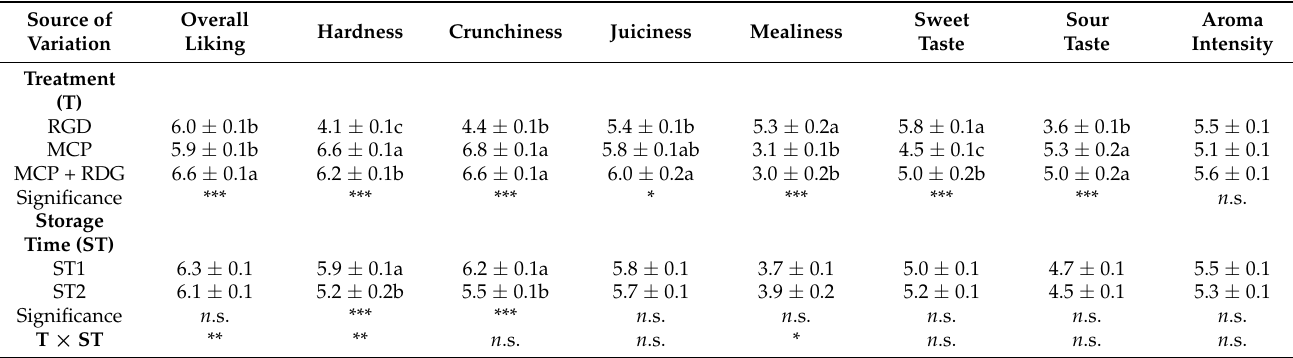
Table 3. Effect postharvest management treatment (T), storage time (ST) and S × T interaction on apples attributes evaluated by a consumer